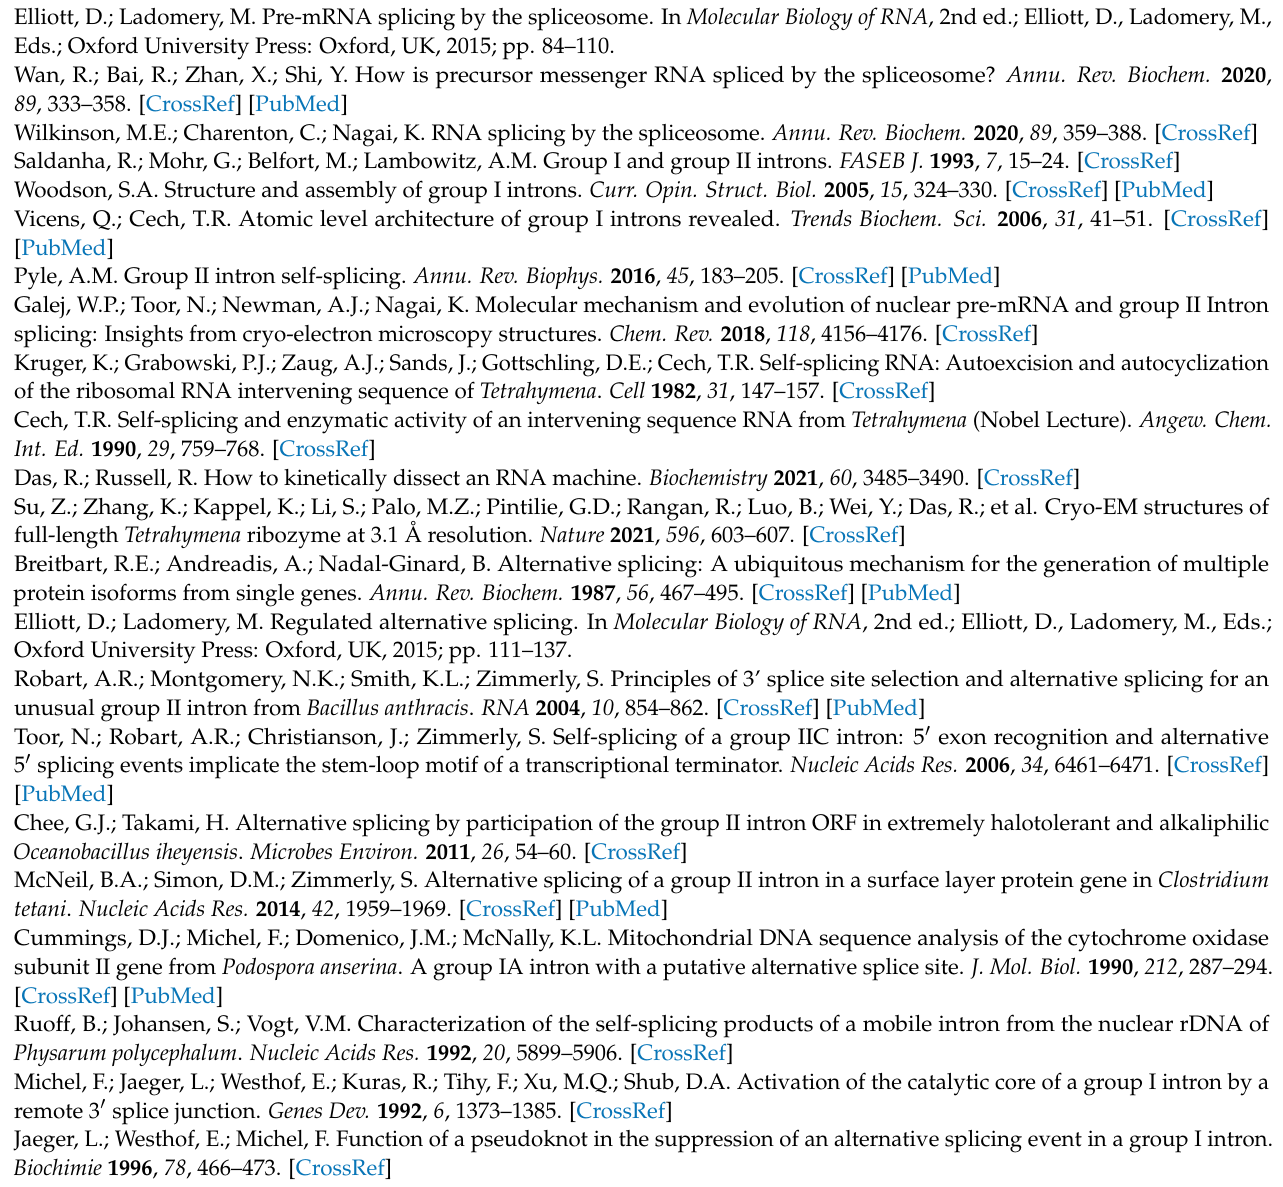
Figure S8: suppression of exon-skipping splicing in tandemly aligned introns with distinct splice site recognition